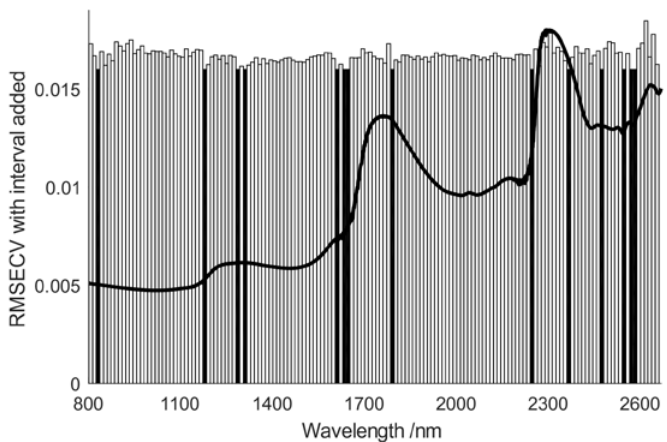
Figure 8. Several interval models (bars) and full spectrum models (solid lines) for cross-validation prediction errors (RMSECV). Note: The preferred interval is given in black.